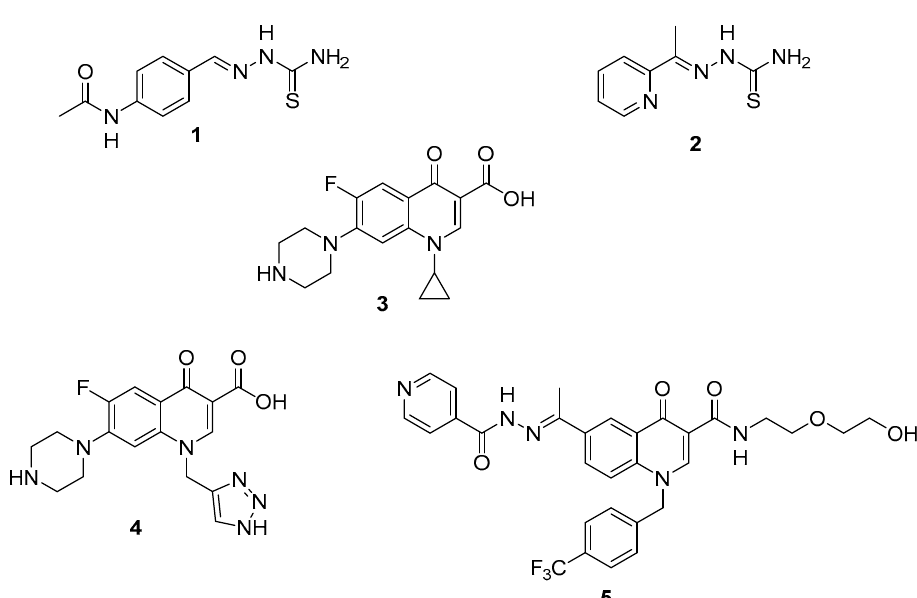
Figure 1. Thiosemicarbazones and quinolones exhibiting antimalarial and anti-TB activity.